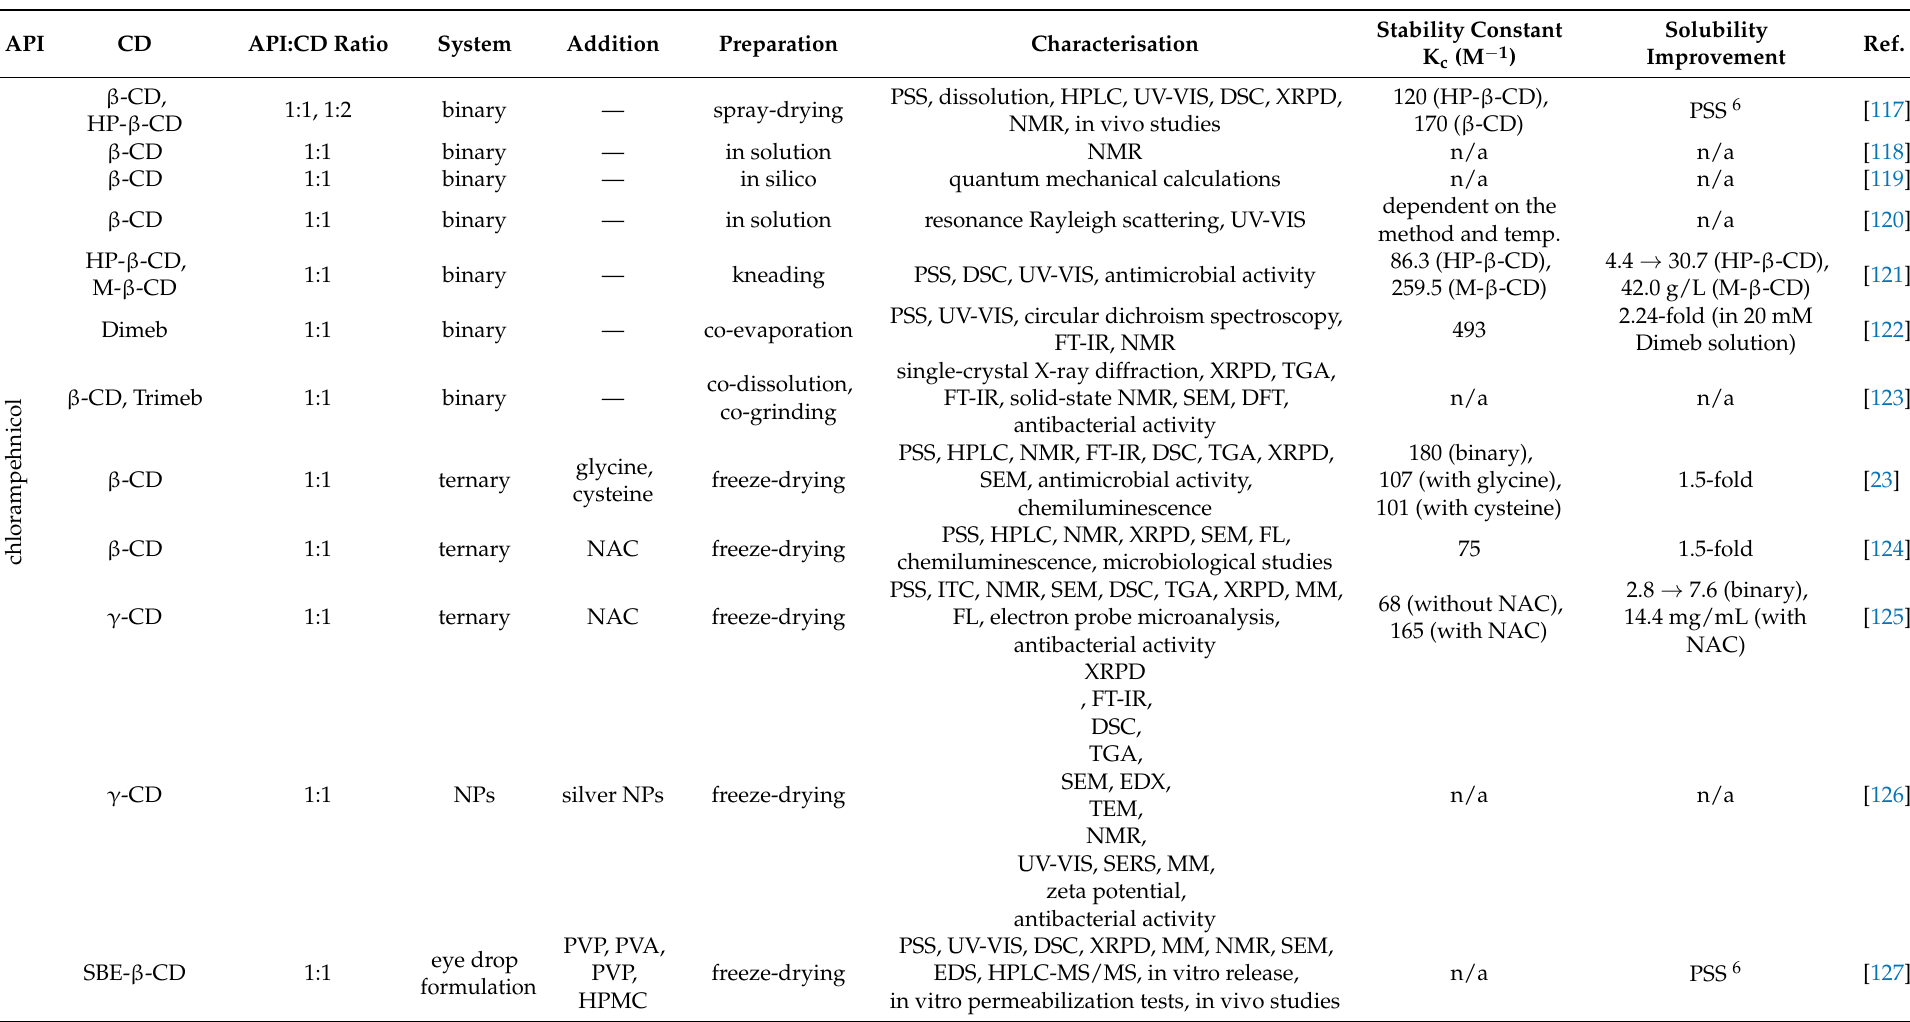
Table 5. Detailed information of chloramphenicol and florfenicol complexes on the types of CDs used, methods of complex preparation, and characterisa- tion techniques